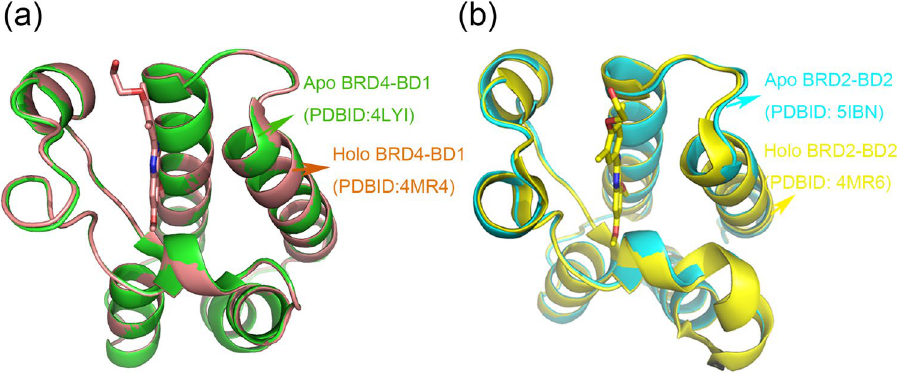
Figure 5. Crystal structural alignment of apo and holo BDs in ( a ) BRD4-BD1 and ( b ) BRD2-BD2